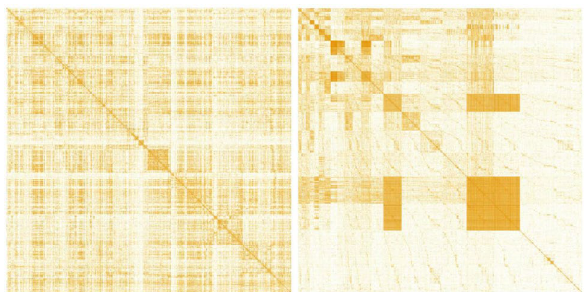
Fig. 1 Left: the similarity matrix between 4088 sentences from Charles Darwin’s Origin of Species . Right: the same matrix with sen- tences reordered in 20 regular groups revealing a characteristic chess- board